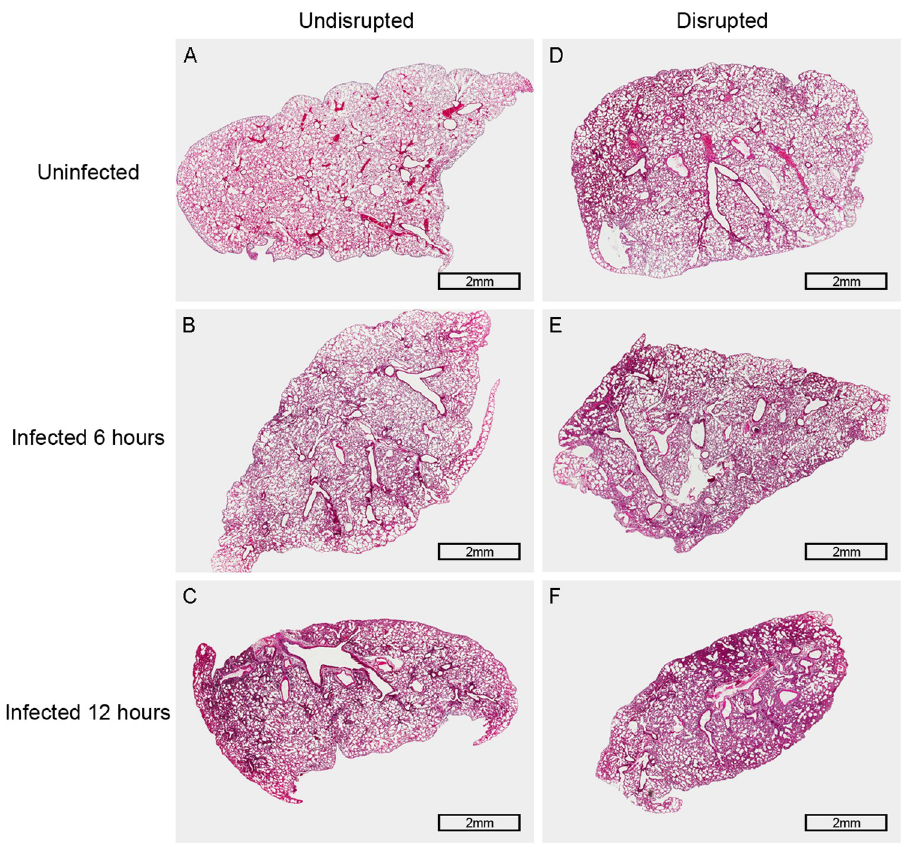
Fig 2. Histopathology of the lung in wild-type mice 6 hours and 12 hours after pneumococcal infection. Representative pictures of H & E stained lung tissues: (A) The picture of the lung tissue in gut microbiota-undisrupted uninfected mice (n = 6 per group). (B and C) Pictures of the lung tissue in gut microbiota-undisrupted mice 6 hours and 12 hours after infection (n = 6 per group). (D) The picture of the lung tissue in gut microbiota-disrupted uninfected mice (n = 6 per group). (E and F) Pictures of the lung tissue in gut microbiota-disrupted mice 6 hours and 12 hours after infection (n = 6 per group). Original magnification, × 20; scale bar = 2 mm.